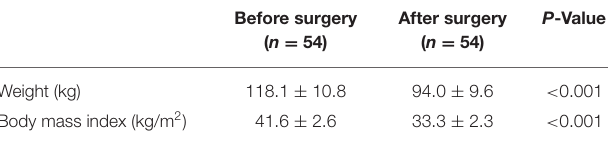
TABLE 1 | Change of weight and body mass index after surgery.